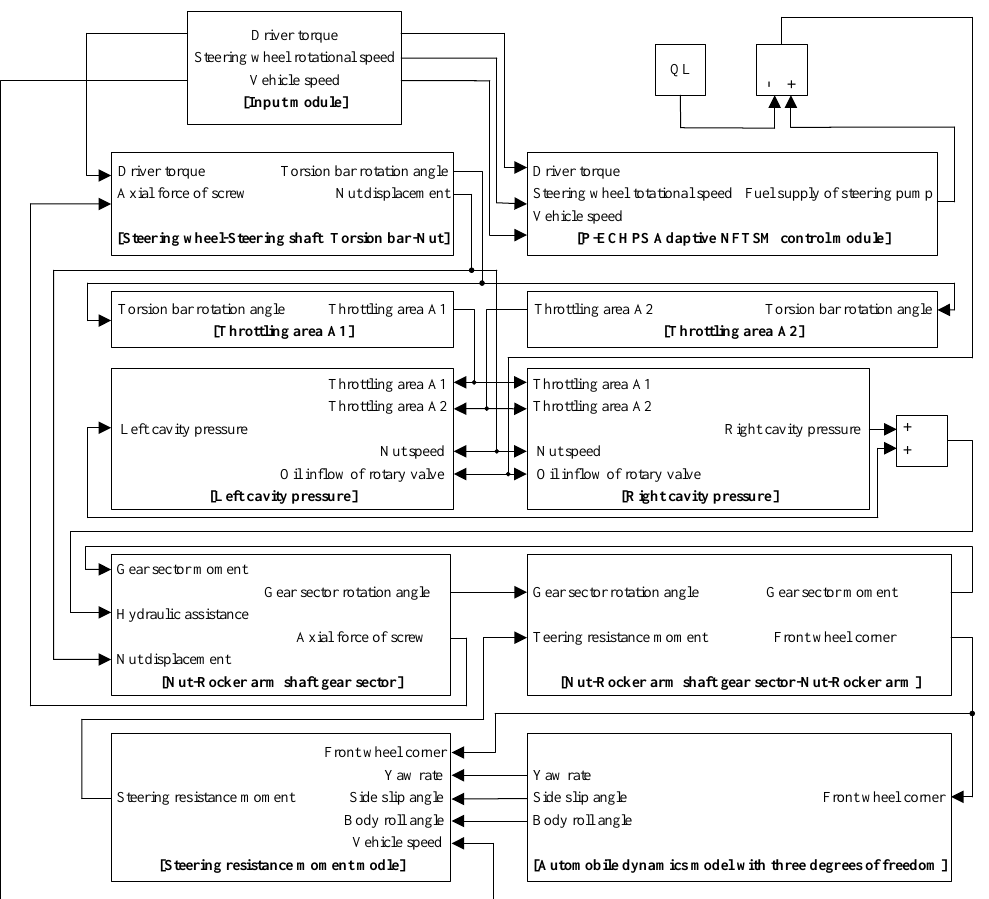
Figure 16. Automobile simulation model of P-ECHPS.